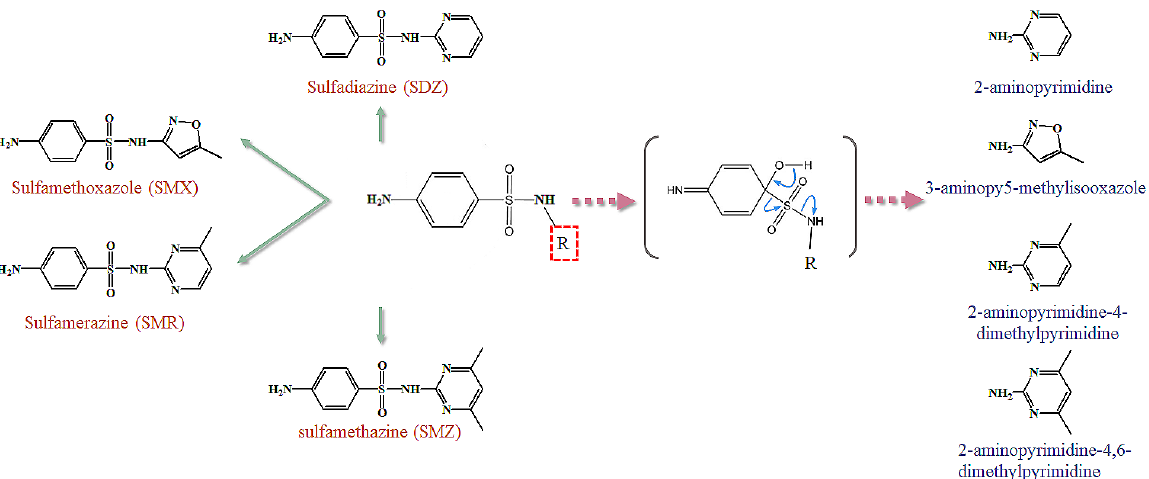
Figure 1. Chemical structures of the sulfonamides used in this study (red) and the end products accumulated after degradation by strain YL1 (blue). ([ · ] denotes that the compound was not detected).